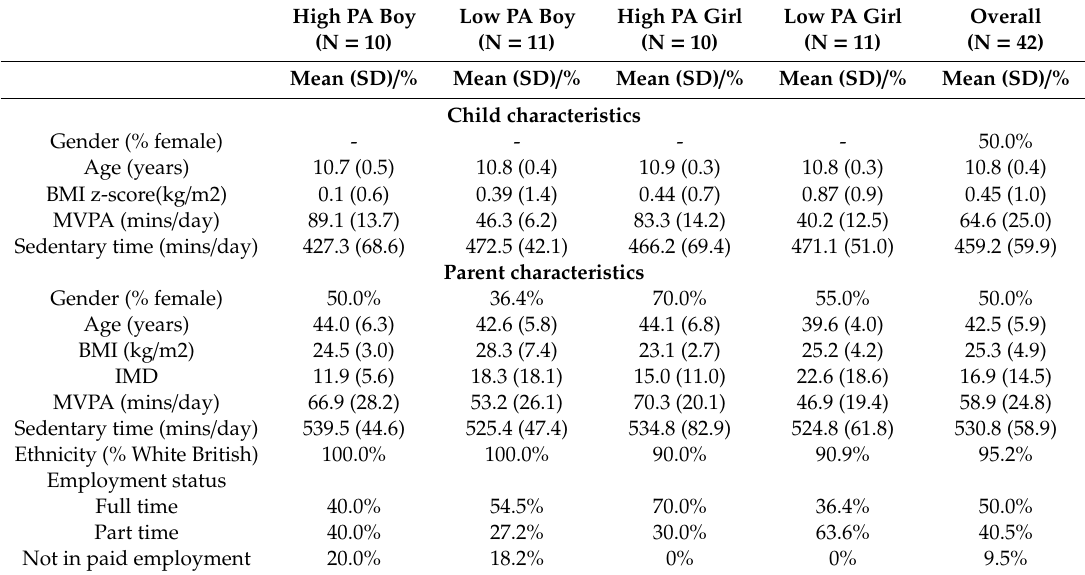
Table 1. Characteristics of the sample of parents ( n = 42) and their children by group and